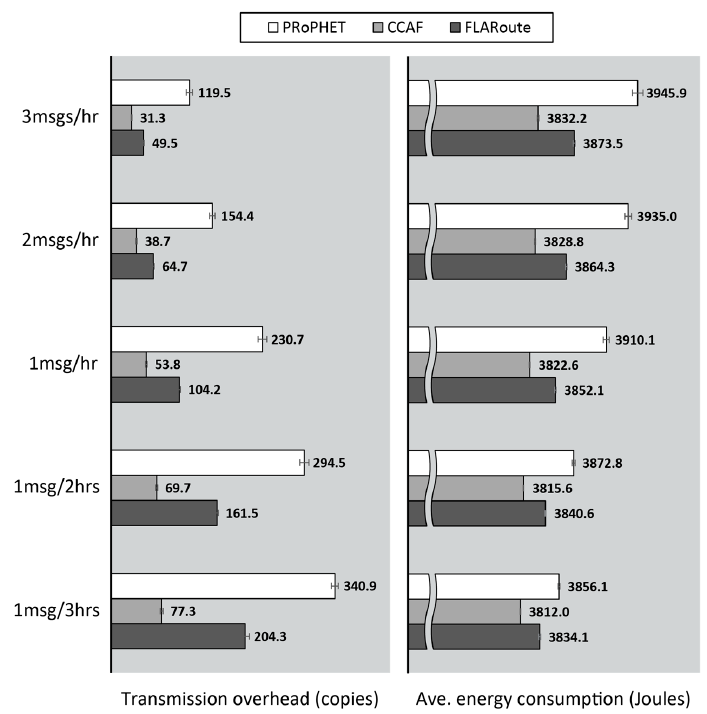
Figure 24. Transmission overhead and average energy consumption under increasing data traffic in the Helsinki scenario.